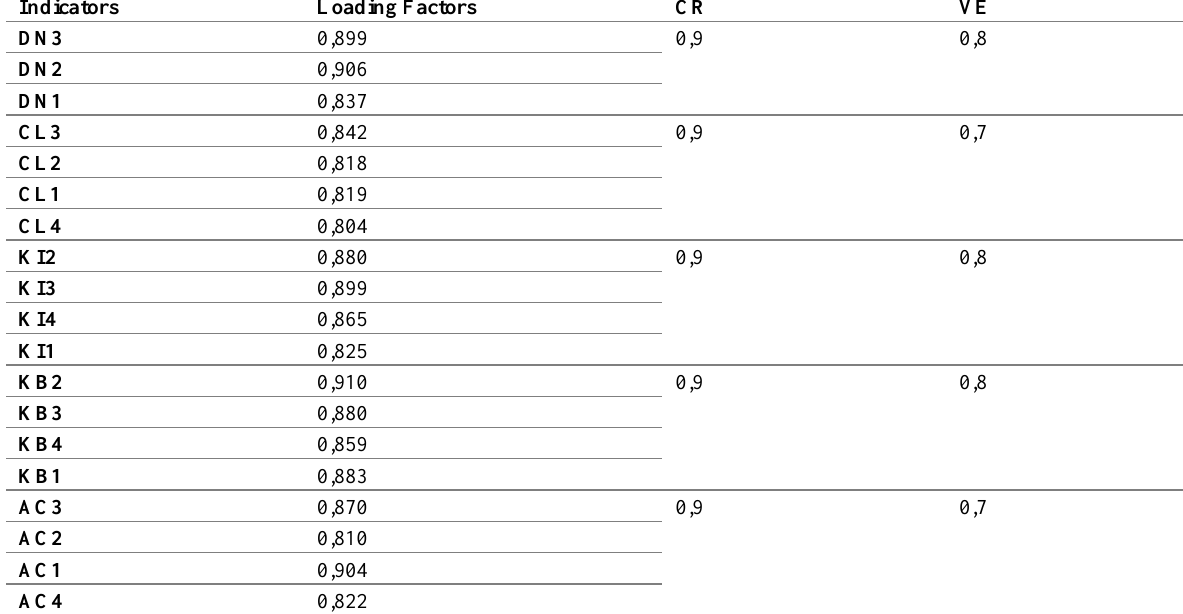
Table 3: Reliability and Validity of